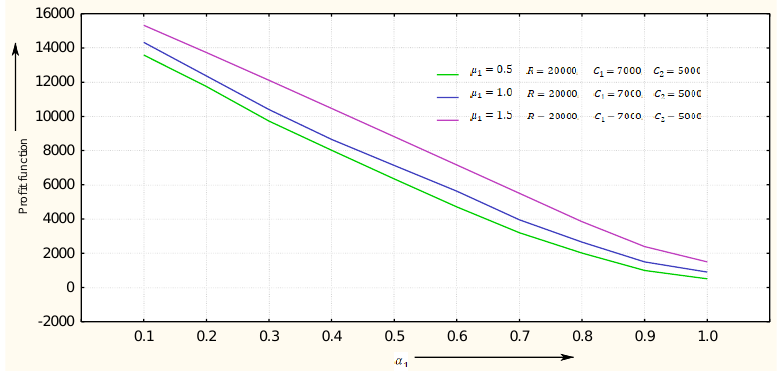
Figure 10. Behaviour of profit function w.r.t 𝛼